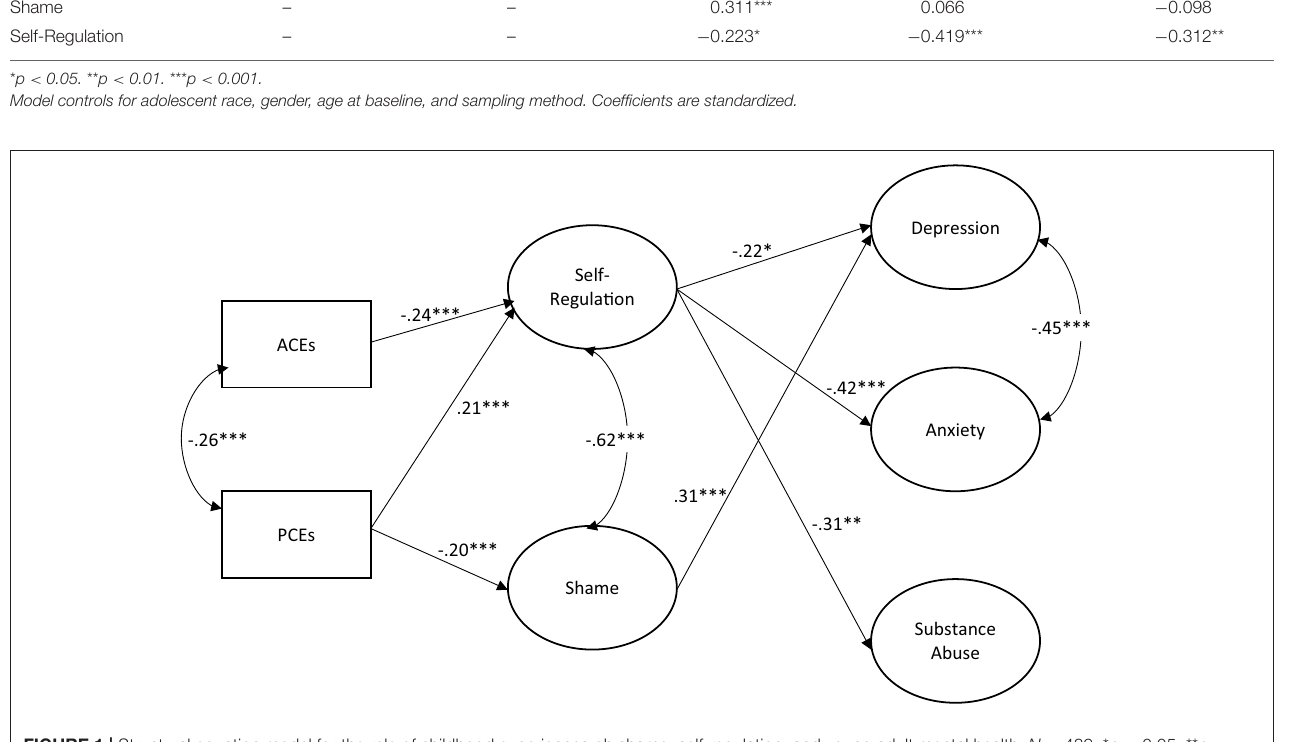
FIGURE 1 | Structural equation model for the role of childhood experiences oh shame, self-regulation, and young adult mental health, N = 489. * p < 0.05. ** p < 0.01. *** p < 0.001. Model fit: RMSEA = 0.049; CFI = 0.946. Model controls for adolescent race, gender, age at baseline, and sampling method. Path coefficients are standardized. Only significant paths are shown.